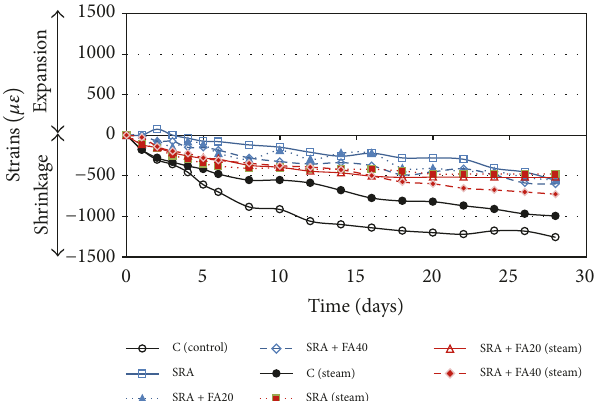
Figure 12: Early age plastic shrinkage results for EX + SRA and EX + SRA +